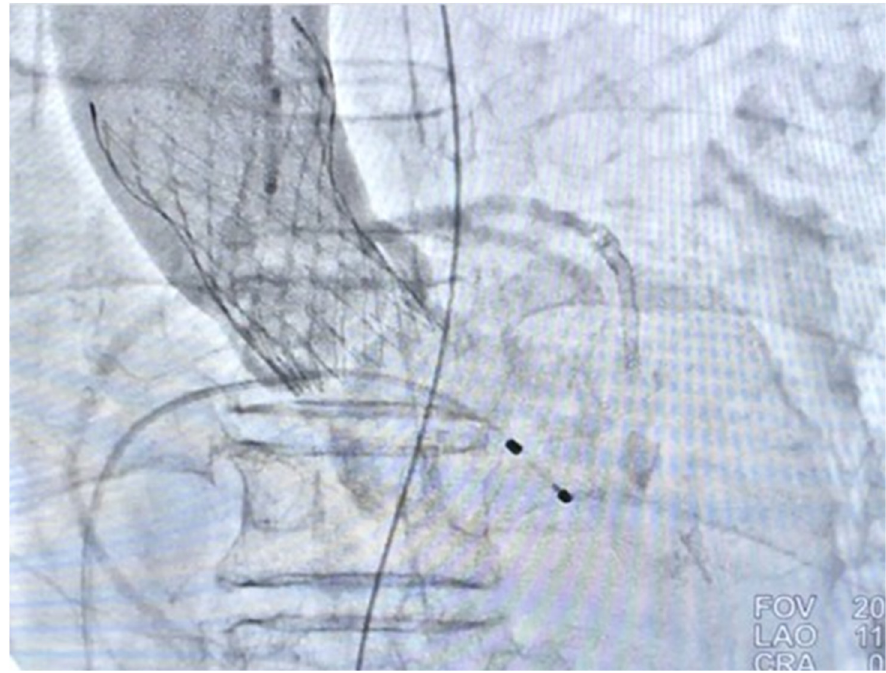
Figure 3. Post-TAVI aorta-gram showing mild aortic regurgitation (AR).